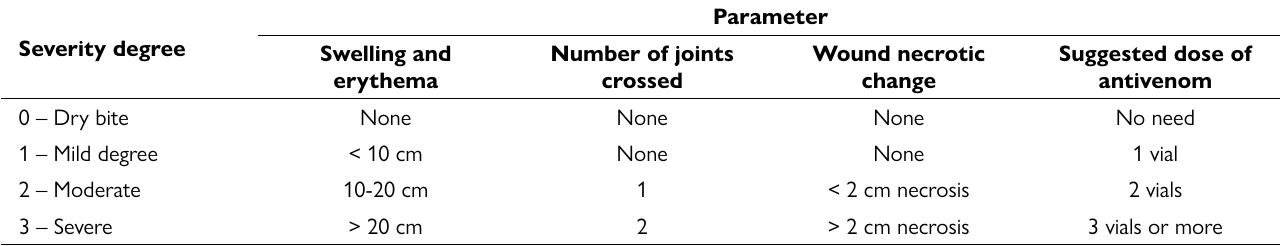
Table 1. Classification of severity degree of snakebite patients in the emergency departments of Taiwanese